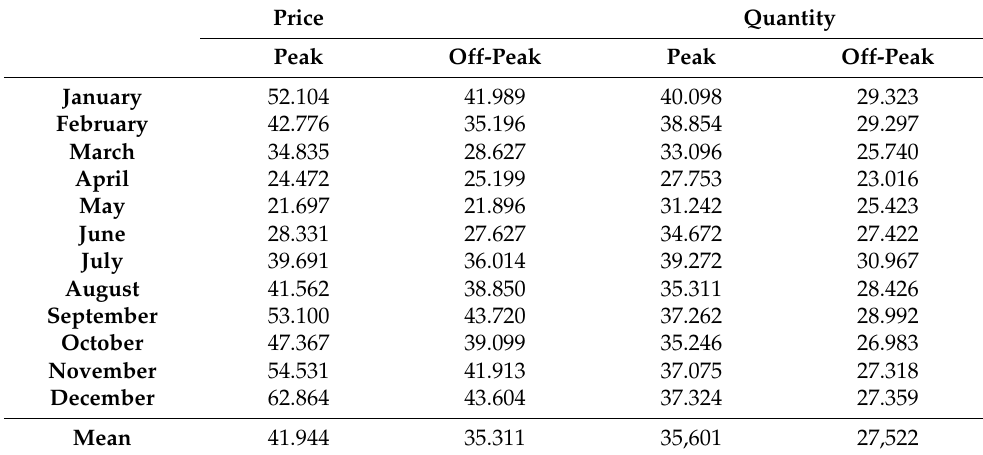
Table 5. Equilibrium Prices and Quantities in the DAM. Monthly Average. Price Quantity Peak Off-Peak Peak